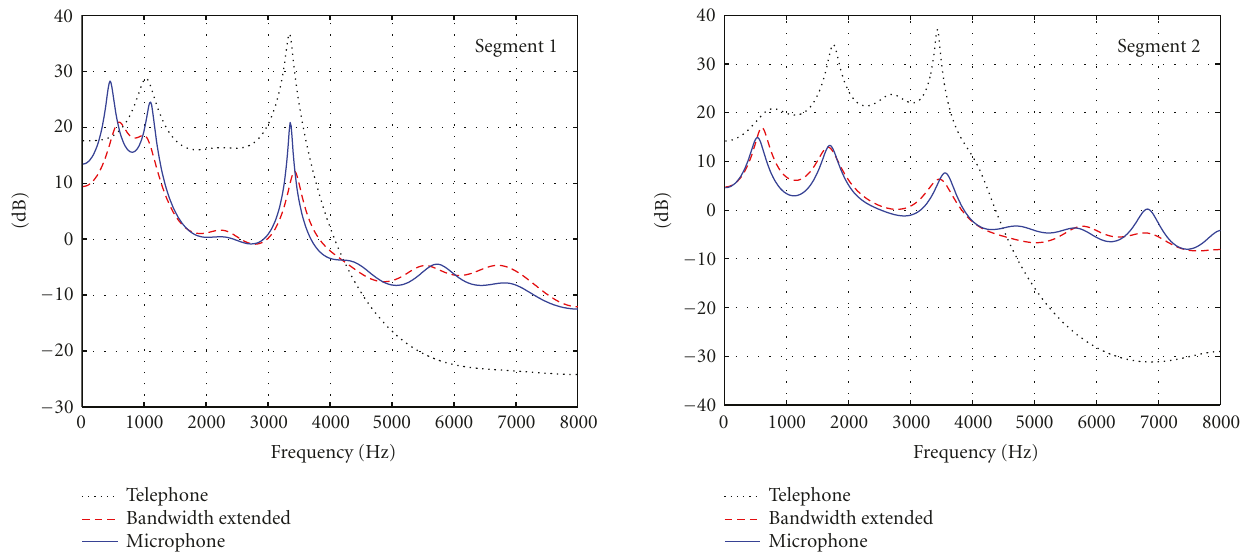
Figure 7: The LP spectra of the telephone speech (dotted line), bandwidth extended speech (dashed line), and NM speech (solid line) for four di ff erent segments of